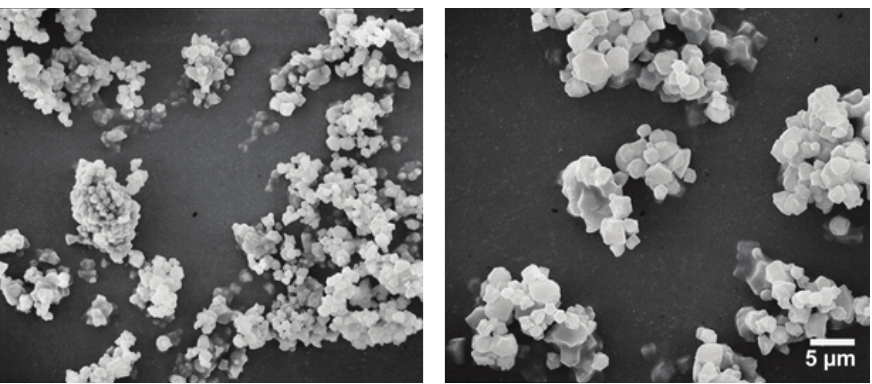
Figure 2: Micrography of Colocasia antiquorum starch (1000 and 2000x). Table 1: Gelatinization parameters of Colocasia antiquorum and Manihot esculenta starch. Starch